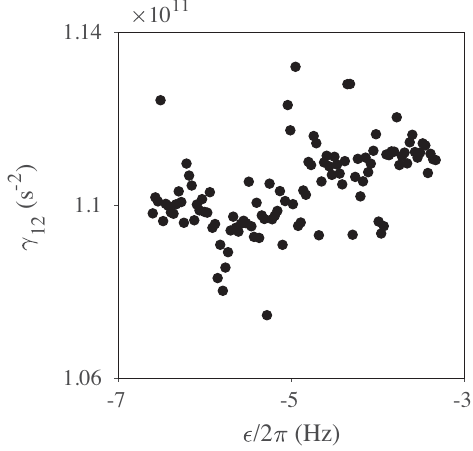
FIG. 5. Dependence of γ 12 on the drive detune ϵ calculated with Eq. (C2). The measured values of u 1 ; 2 from the isolated branches in Figs. 2(a) and 2(c) are used.